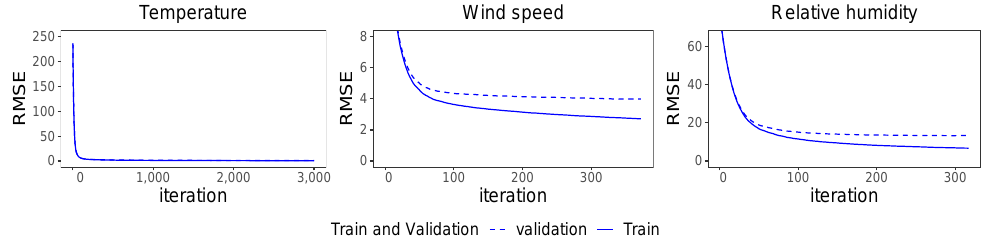
Figure 18. Ten-fold cross-validation RMSE by iteration using GBM. Train and validation sets are distinguished by solid and dashed